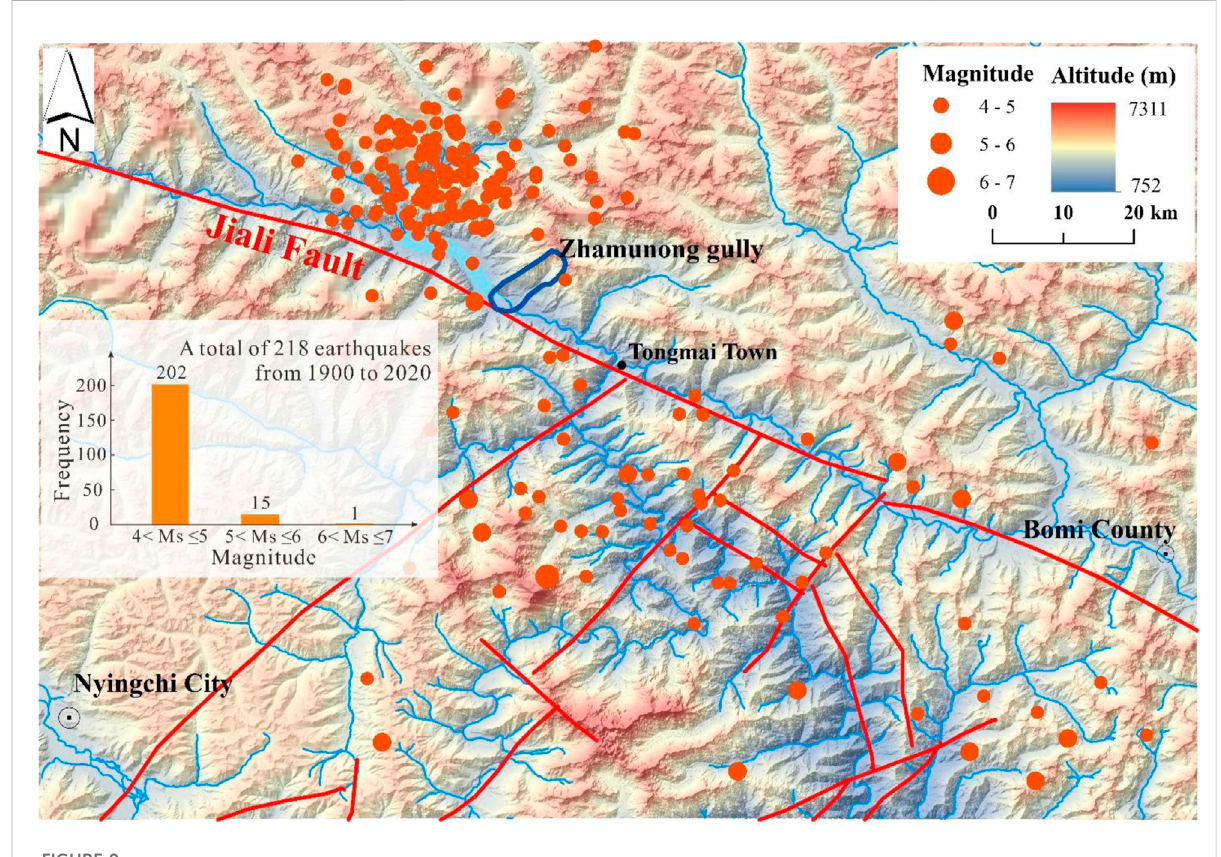
FIGURE 9 Distribution of earthquakes and faults in the Yigong area over the years (Fault modi fi ed after Xu et al.,